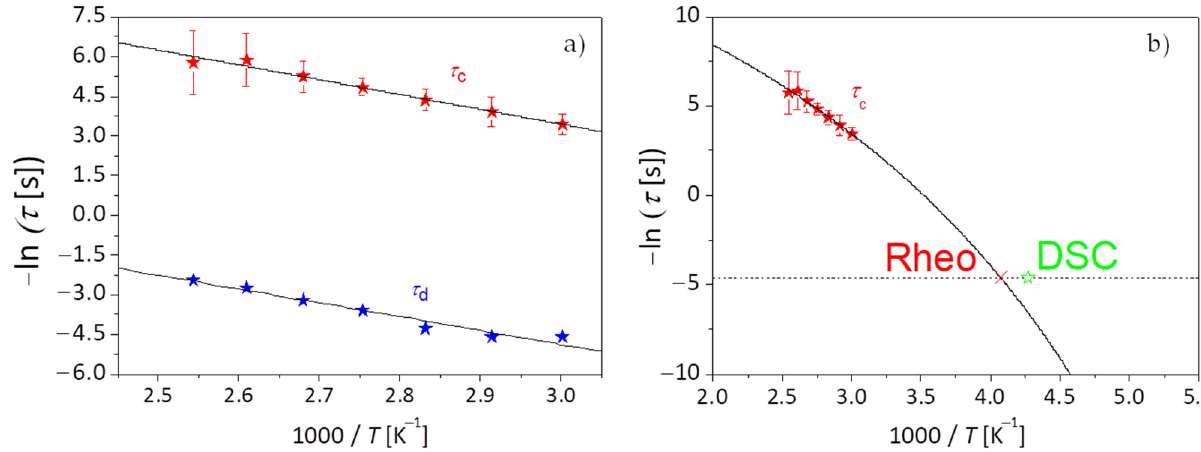
Figure 8. ( a ) Temperature dependence of the relaxation times for PEG-upy. Red stars: network longest relaxation time ( τ c ) and blue stars, network detachment relaxation time ( τ d ). The lines are the fits to the data using the VFTH and Arrhenius laws, Equations (6) and (7), respectively. ( b ) Temperature dependence of the network longest relaxation time ( τ c ) for supramolecular PEG-upy in comparison with the calorimetric glass transition obtained by DSC analysis. The dotted line corresponds to a τ = 100 s and the red cross indicates the T g obtained using the VFTH fit to the rheological segmental relaxation time data.